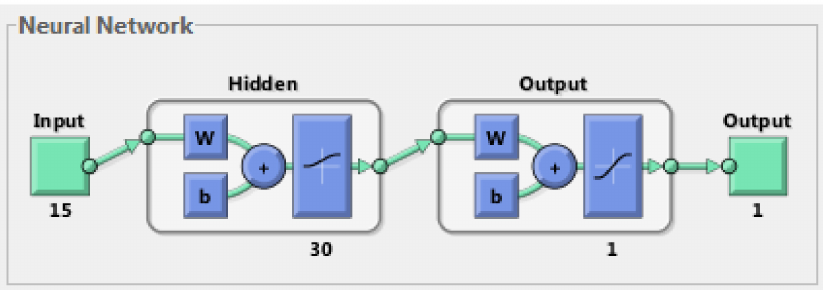
Figure 14. Proposed multilayer perception (MLP) neural network framework.